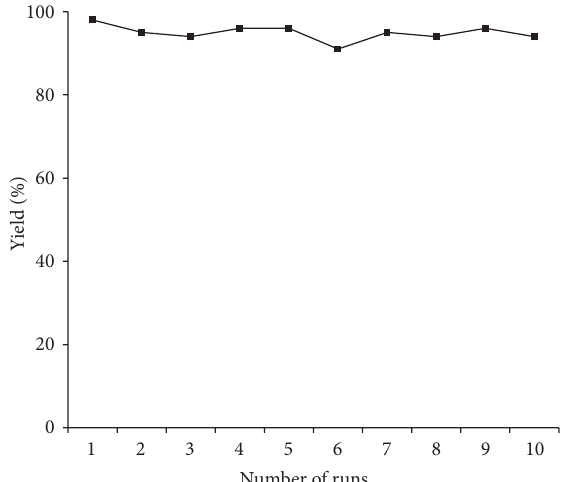
Figure 5: Recyclability of XL-QPPd resins on Suzuki cross-coupling reaction between the phenylboronic acid and 4-bromoacetophe-